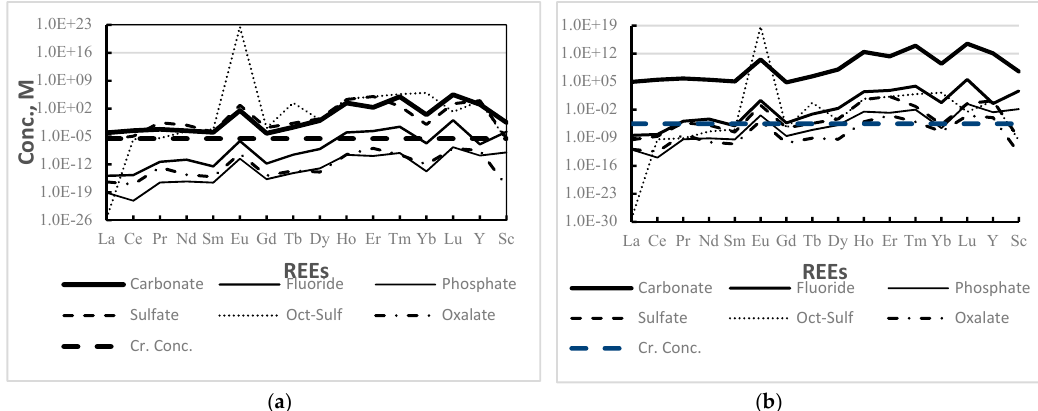
Figure 7. Concentration of Re 3+ in equilibrium with various precipitants at 10 − 4 M and at ( a ) pH 4 and ( b ) pH 1.